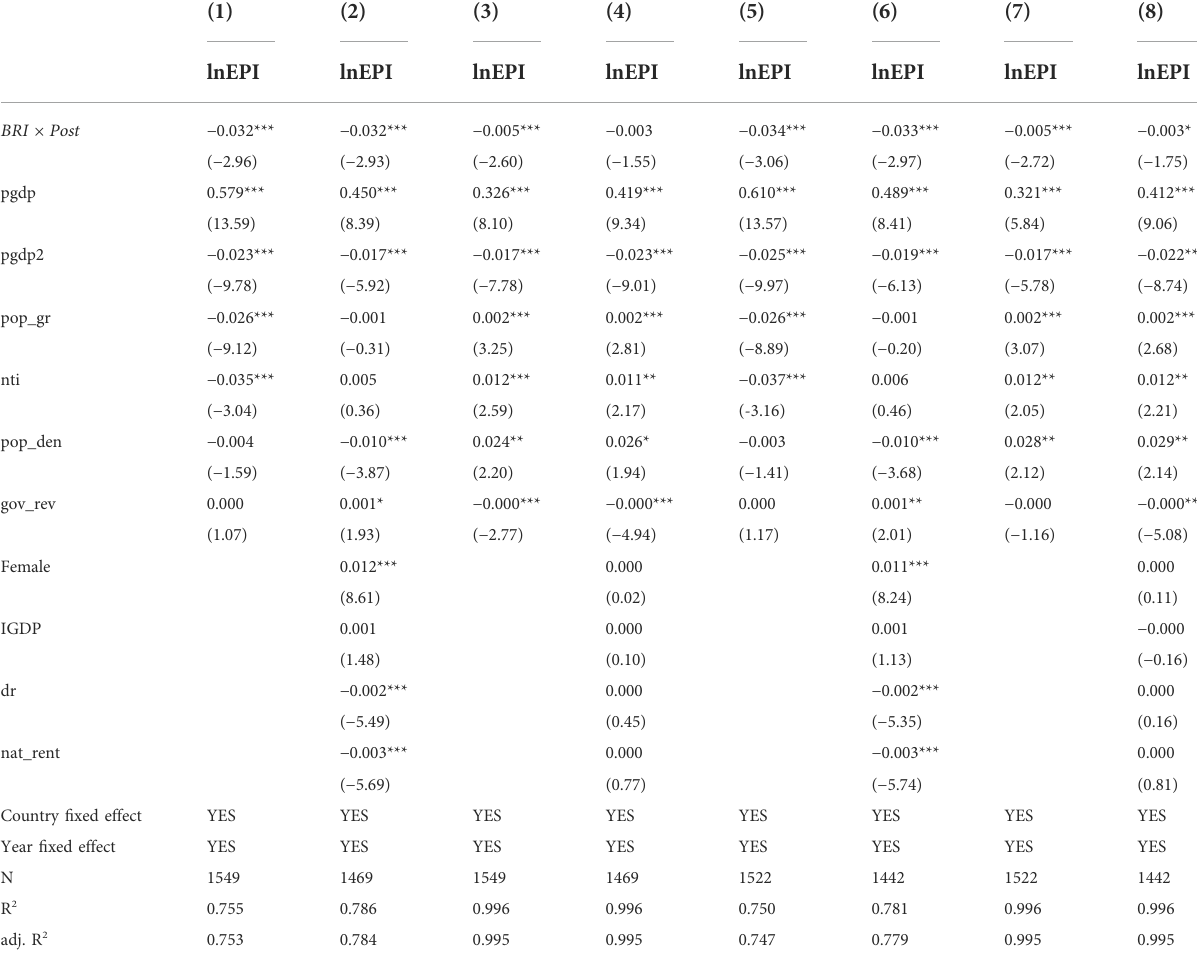
TABLE 7 Effects of the Belt and Road Initiative on environmental quality: Instrumental variable